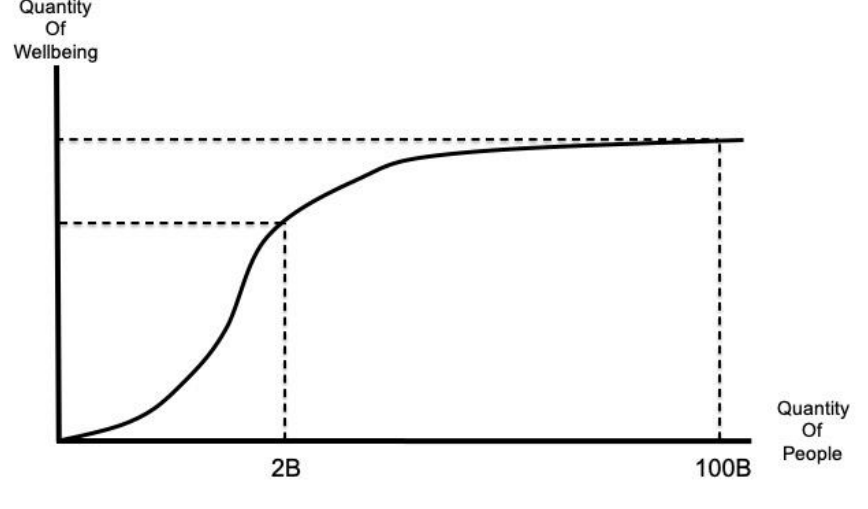
Figure 3: Repugnant View of